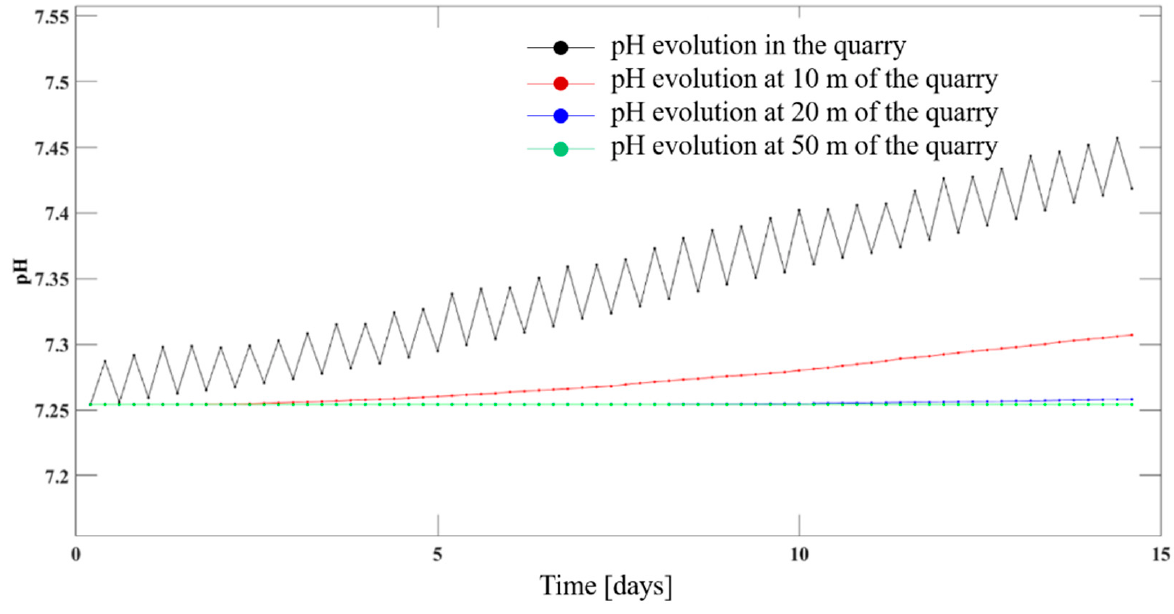
Figure 10. pH evolution in the quarry and at 10, 20, and 50 m around the quarry.